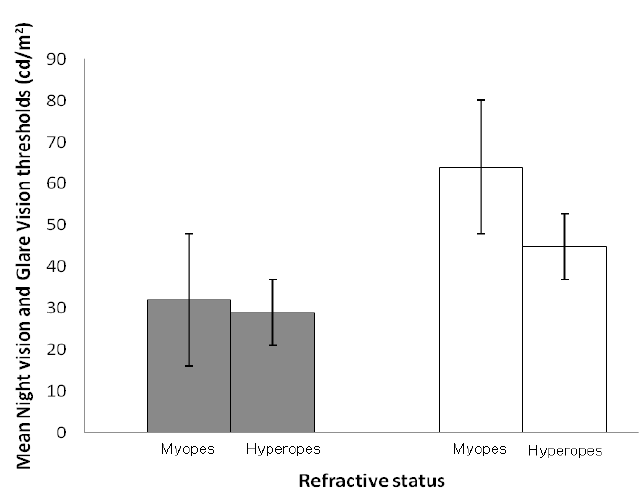
Figure 1 : Showing the mean night vision (grey bars) and glare vision (clear bars) thresholds of the myopic and hyperopic eyes. The grey bars show that the mean night vision threshold of the myopic eyes is higher than that of the hyperopic eyes. Also, the clear bars show that the mean glare vision threshold of the my- opic eyes is higher than that of the hyperopic eyes.